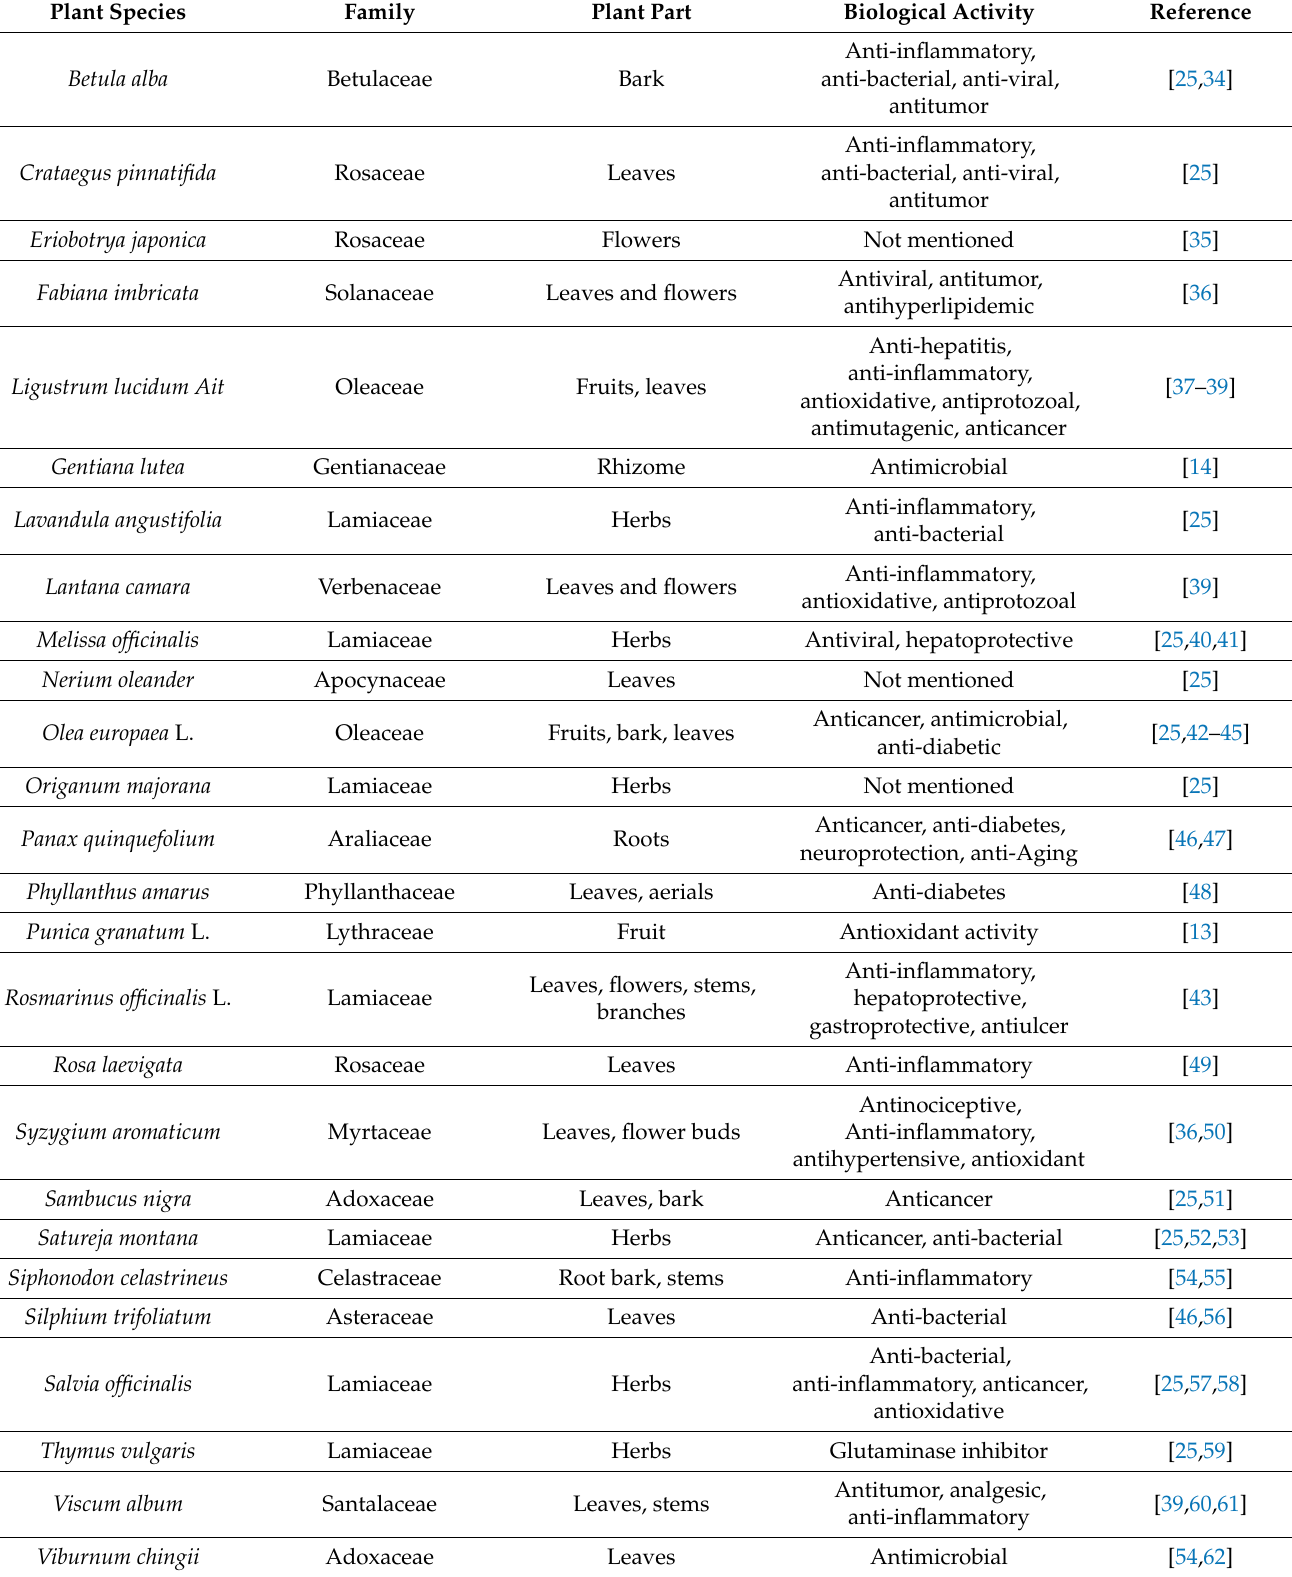
Table 1. Natural sources of